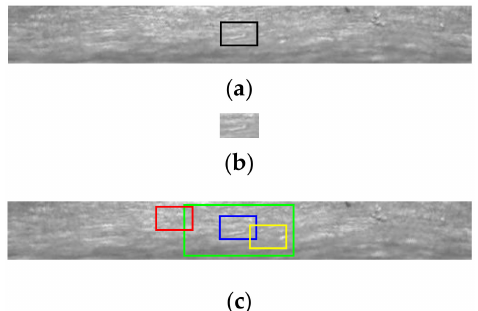
Figure 17. Three candidate images in a smooth borehole image. ( a ) Resource image; ( b ) template and ( c ) examined